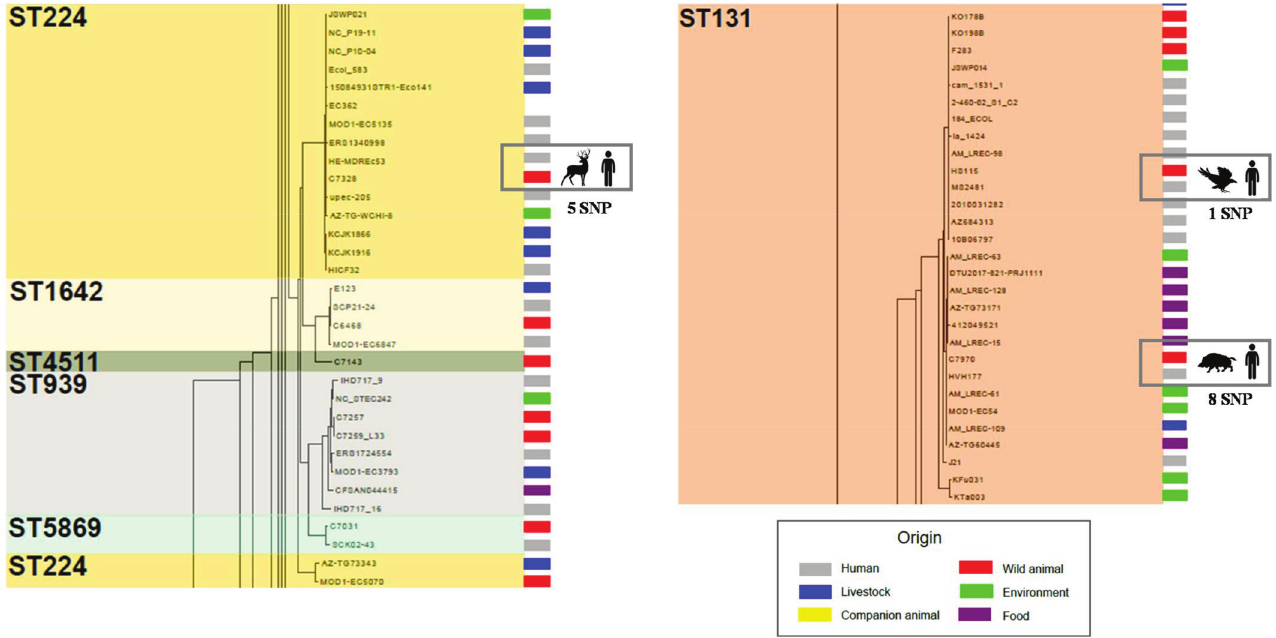
Figure 7. Overview of two of the most populated branches of the core genome tree. The very low number of SNP differences observed between strains from wild animals and humans are highlighted in squares. Moreover, ST224 cluster also shows the higher discriminatory power of WGS when compared to conventional MLST